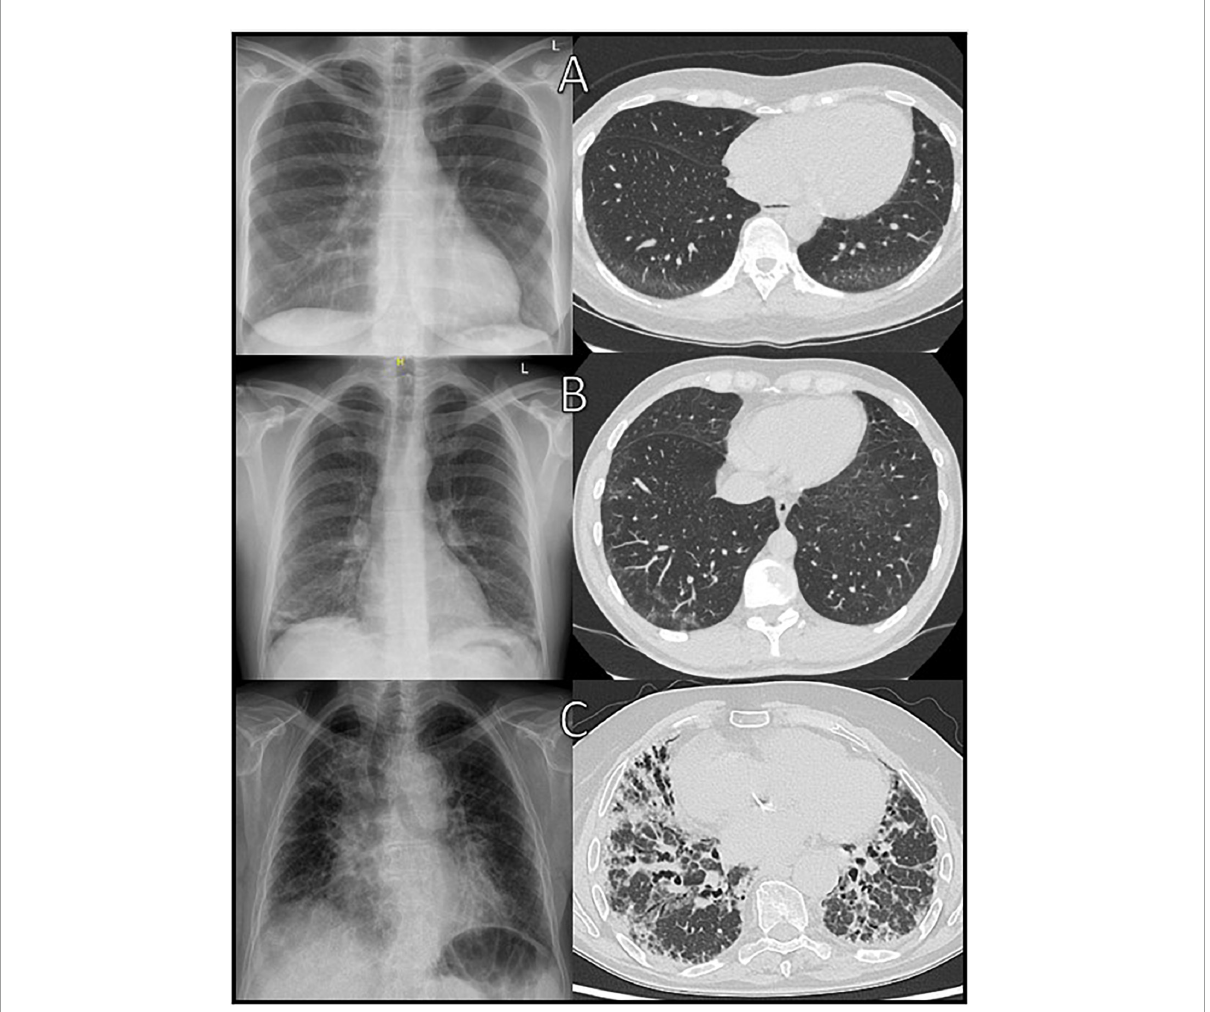
FIGURE1 Comparison of chest X-ray with HRCT at initial diagnosis of ILD. (A) Early Sharp syndrome with ground-glass opacities in HRCT and inconspicuous chest X-ray, (B) early systemic sclerosis with ground-glass opacities, reticulations (early NSIP-pattern), and small consolidations in chest X-ray and (C) end-stage Sjögren’s syndrome with distinct consolidations in chest X-ray and beginning UIP-pattern in